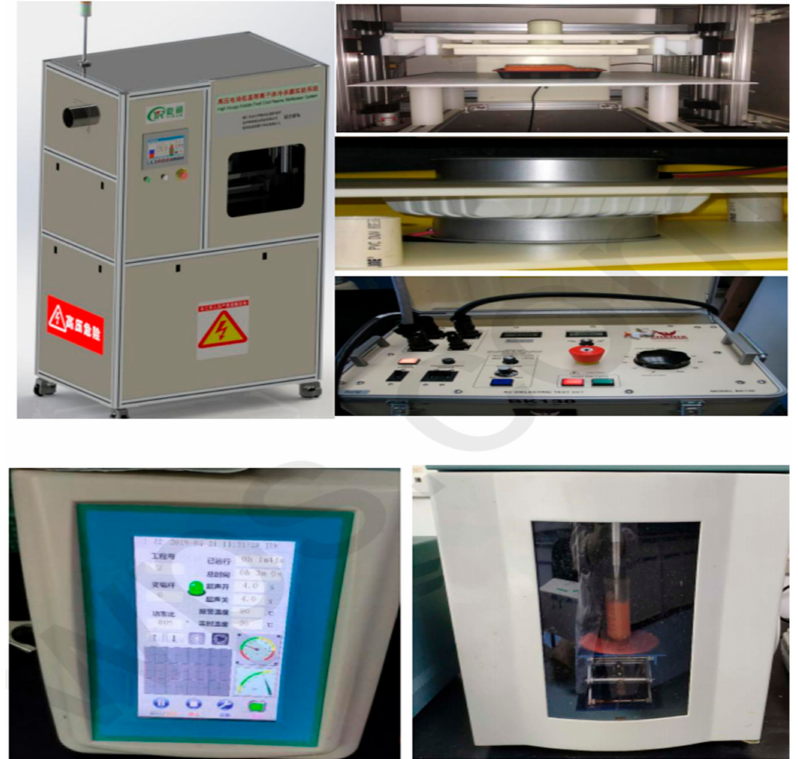
Figure 1. Schematic diagram of the ultra-sonication in combination with high voltage cold plasma (US-HVCP) treatment of carrot